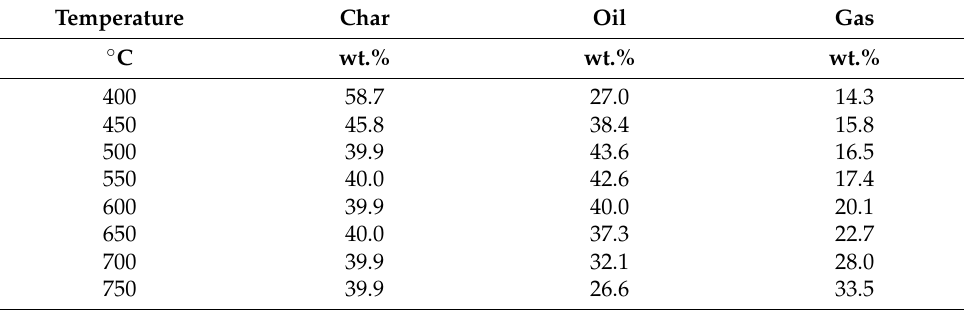
Table 2. The effects of temperature on pyrolysis products